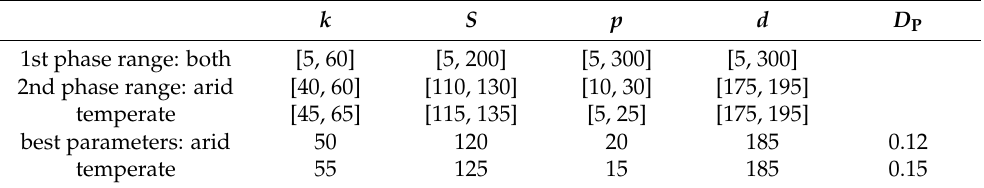
Table 2. Segmentation parameters and images acquired in arid and temperate periods.